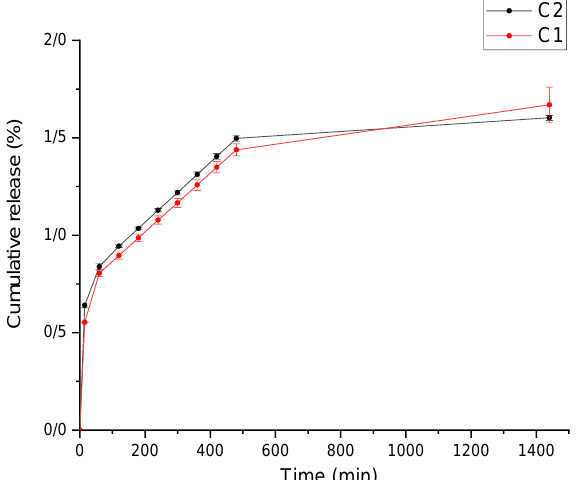
Figure 5. Release of curcumin from composite films in 50% ethanol fatty food simulant. C1 (1GE: 1 SFTG/curcumin); C2 (2GE: 1SFTG/curcumin).